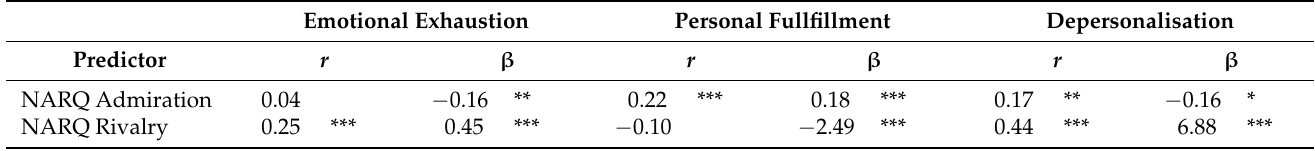
Table 13. Summarizing